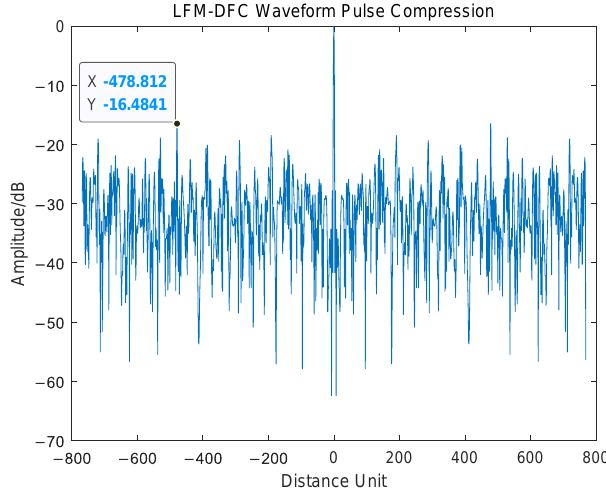
Figure 12. LFM -DFC Waveform Pulse Compression.